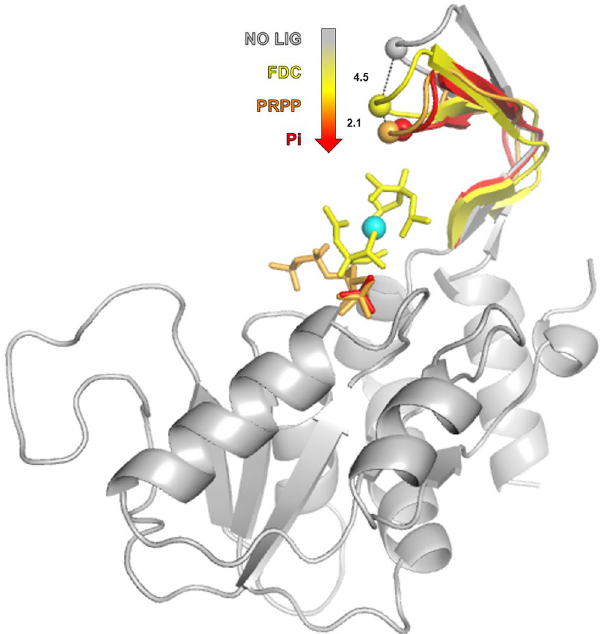
Figure 5. Conformational changes in the OPRTase. Superposition of the monomeric structure of ligand- free MtOPRTase monomer (grey) and in complex with FDC (yellow), PRPP (orange) and Pi (red). The arrow highlights the movement of the hood domain according to the ligand present in the active site. Ser26 C α ’s are shown as spheres according to ligand and structure colours; distances between Ser26 C α ’s are expressed in